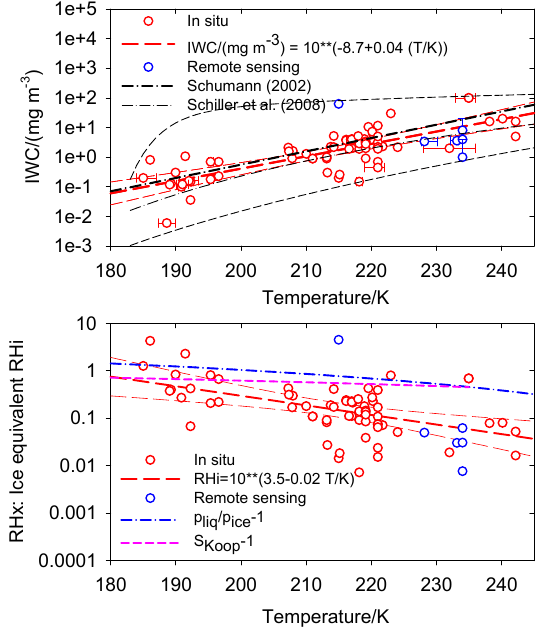
Figure 5. Top: Ice water content (IWC) versus temperature T from in situ (red) and remote sensing observations (blue symbols) with a regression line for the in situ data (red; with given formula and with 99% confidence ranges, red dashed). The thick black dash-dotted line depicts an earlier parameterization (Schumann, 2002). The thin black lines represent median (dash-dotted) and maximum/minimum values (dashed curves) from in situ measurements in cirrus (Schiller et al., 2008). Bottom: ice-equivalent relative humidity (RH x ) over ice versus temperature (1 = 100%), with a regression line (red dashed; with 99% confidence ranges, thin red dashed), and with ex- pected RH x values for ice forming from ambient supersaturation at liquid saturation (blue dash-dotted) and at the critical humidity for homogenous nucleation (Koop et al., 2000; Kärcher and Lohmann, 2002) (purple dashed line).